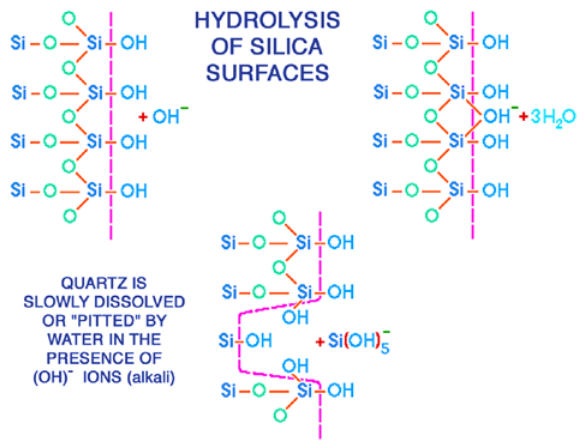
Figure 7. The molecular dispersion from crystalline silica in water as Si(OH) 4 is catalysed by hydroxyl ions of an alkali or base. Sea- water is slightly alkaline and therefore silica (and most silicate sur- faces) “disperse” by these surface reactions. In sea water and within marine sediments the small neutral Si(OH) 4 molecules polymerise to short chain polymeric silicic acids called “oligomers”. (From Iler, 1979, fig. 1.11.)